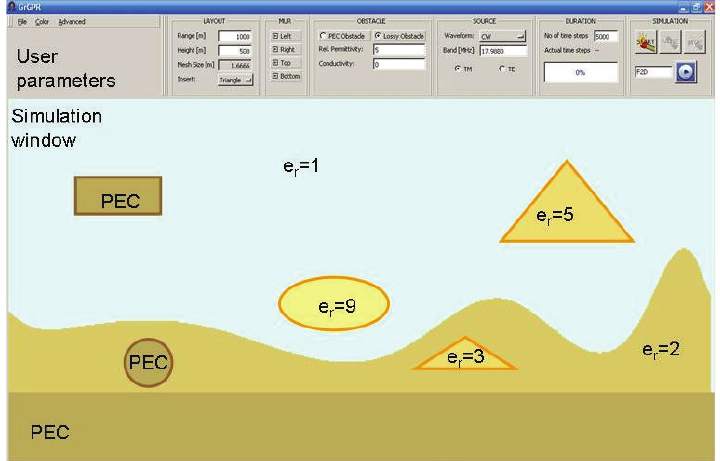
Figure 1: The front panel of the GrGPR virtual tool and user-created, either perfect electrical conductor (PEC) or lossy, triangular, rectangular, and/or elliptical objects.